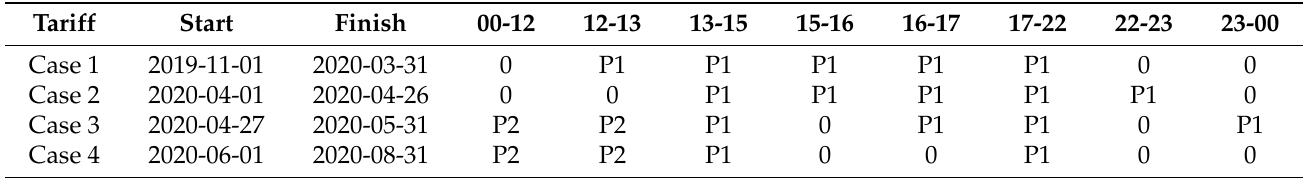
Table 3. Different experimental pricing tariff